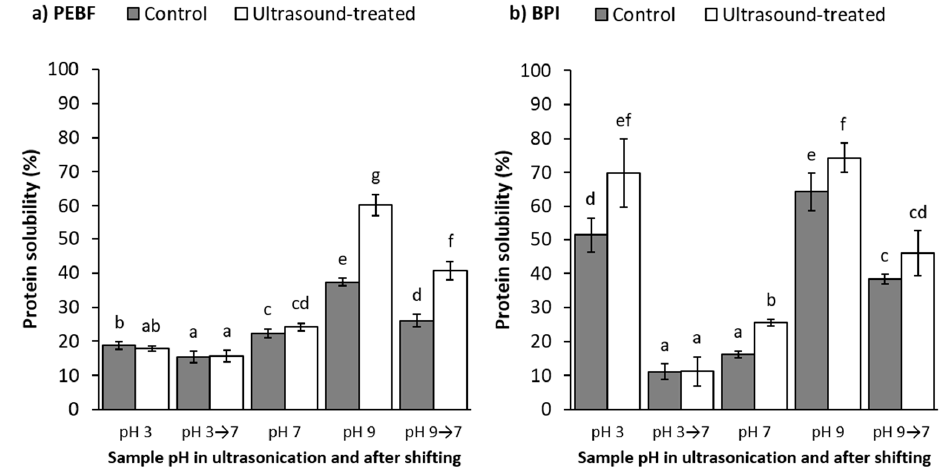
Figure 3. Impact of ultrasound treatment and pH on protein solubility of ( a ) protein-enriched barley fraction (PEBF) and ( b ) barley protein isolate (BPI). Shifting the sample pH to 7 after ultrasound treatment is indicated with an arrow. Values represent means and error bars standard deviations of 2–4 parallel protein analysis performed after each of the two replicate extractions ( N = 6–10). Results with different letters, separately for the two raw materials, are significantly ( p < 0.05) different from each other.